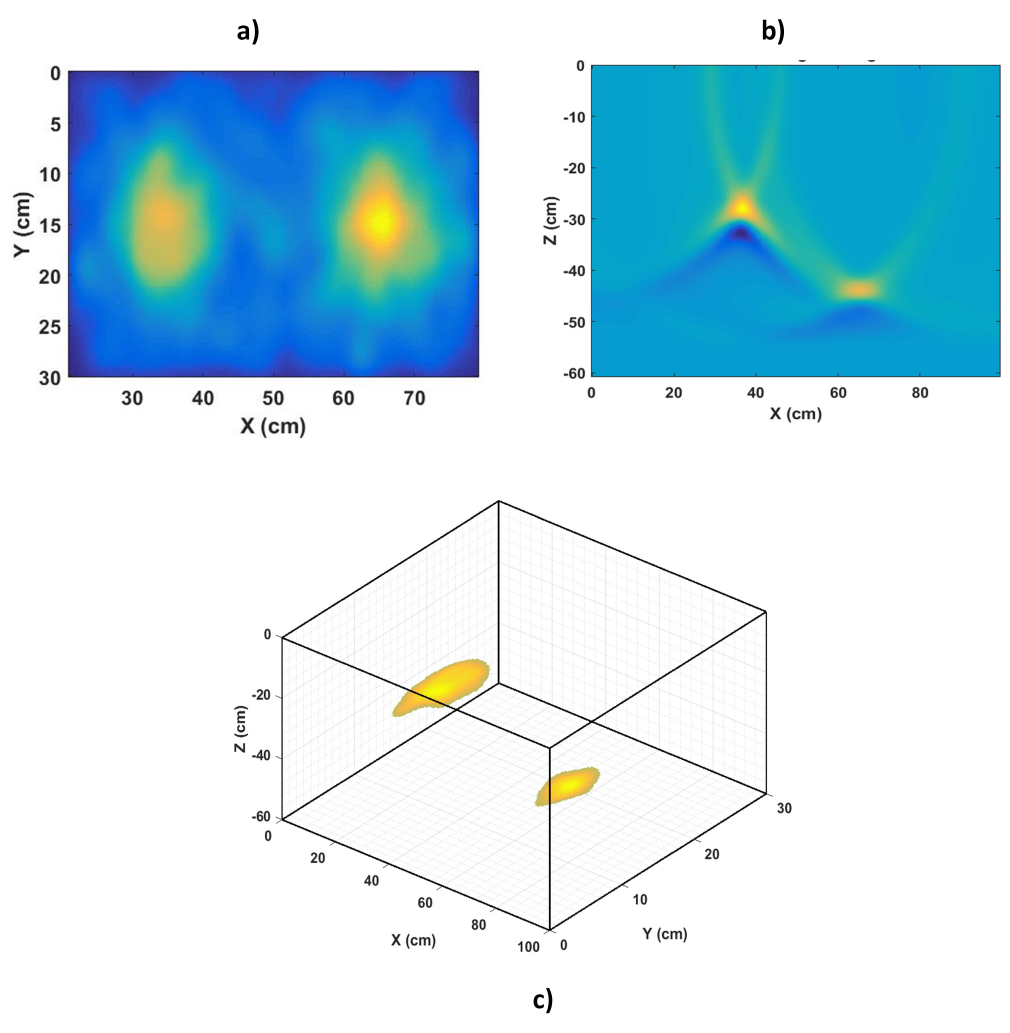
Figure 14. ( a ) Ground level image of radiation sources; ( b ) matched filtered GPR image of pipes; ( c ) 3D localised image of radiation